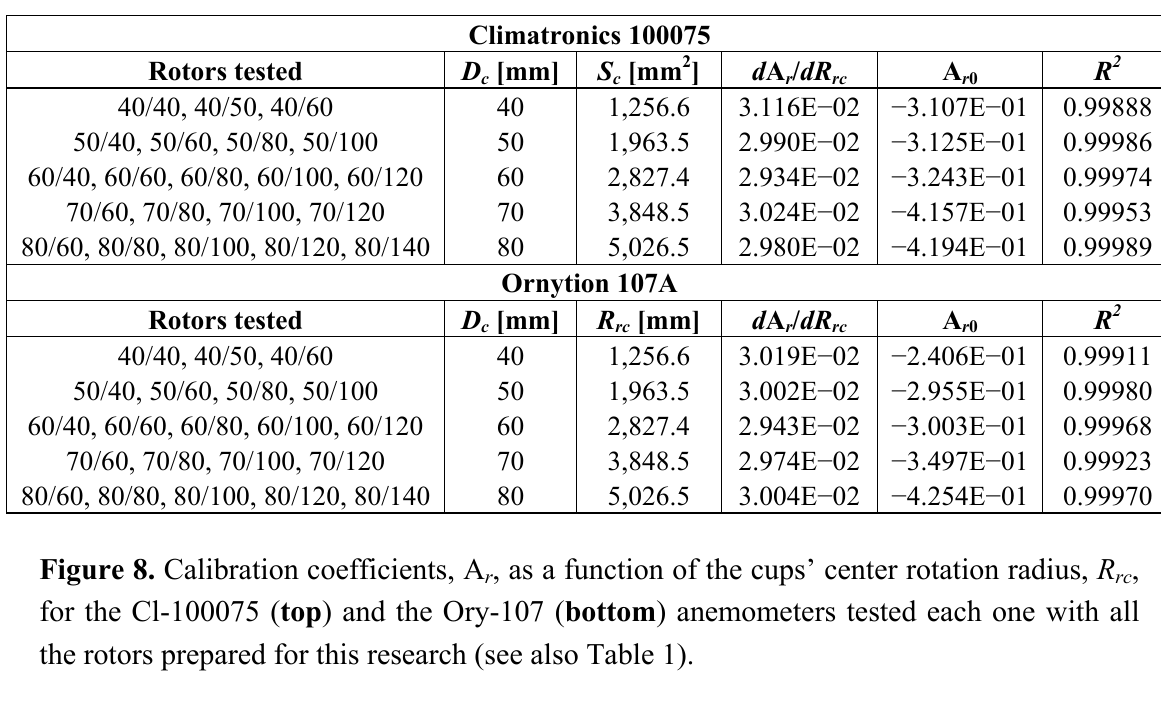
Table 2. Linear fittings (slope, d A calibration constants A calibrations performed on Climatronics 100075 and Ornytion 107A anemometers, equipped with the same rotors. The diameter, D included.